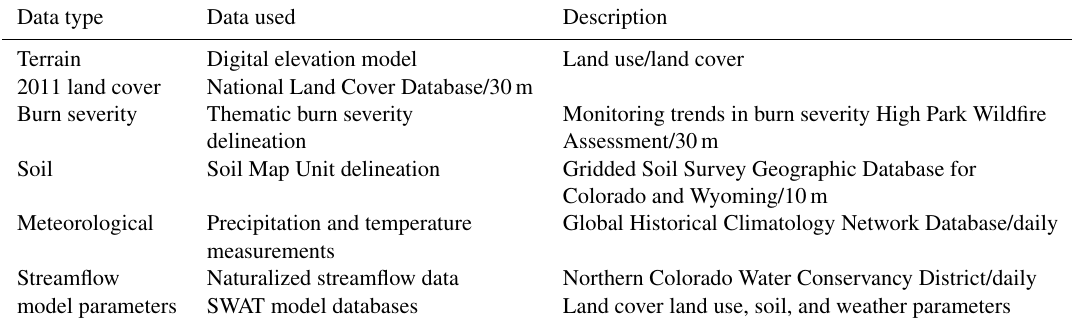
Table 1. SWAT model input